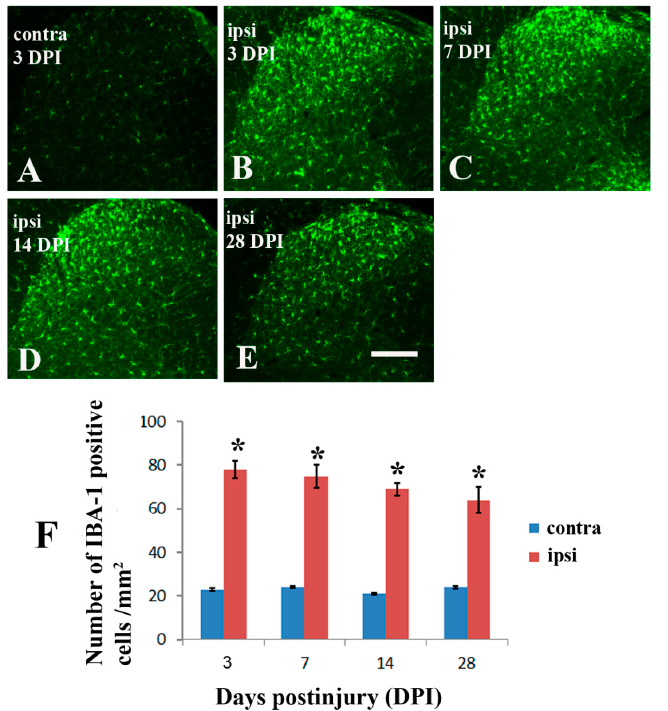
Figure 3. Immunohistochemistry for IBA-1 in spinal dorsal horns following nerve ligation of brachial plexus in TgCRND8 mice at the age of 20 months. ( A ): IBA-1 expression of the contralateral side (contra) following the nerve ligation. ( B – E ): IBA-1 expression of the ipsilateral side (ipsi) at 3, 7, 14, and 28 days after nerve ligation (DPI). ( F ): Comparison of changes in the IBA-1 expression at 3, 7, 14, and 28 days between the contralateral and ipsilateral side of dorsal horn. * Significant differences between the two sides, p < 0.01. Scale bar, 120 μ m.